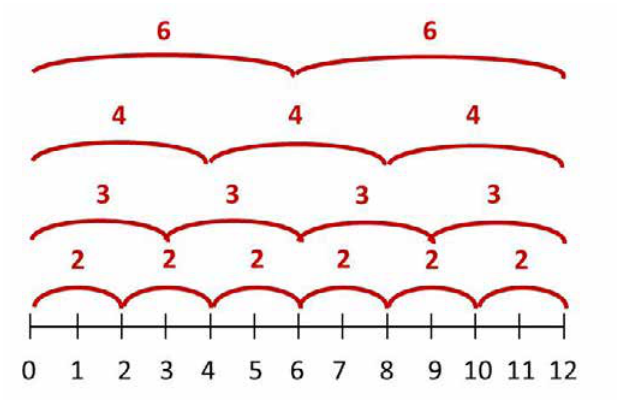
Figure 7: Bundling and unbundling the number